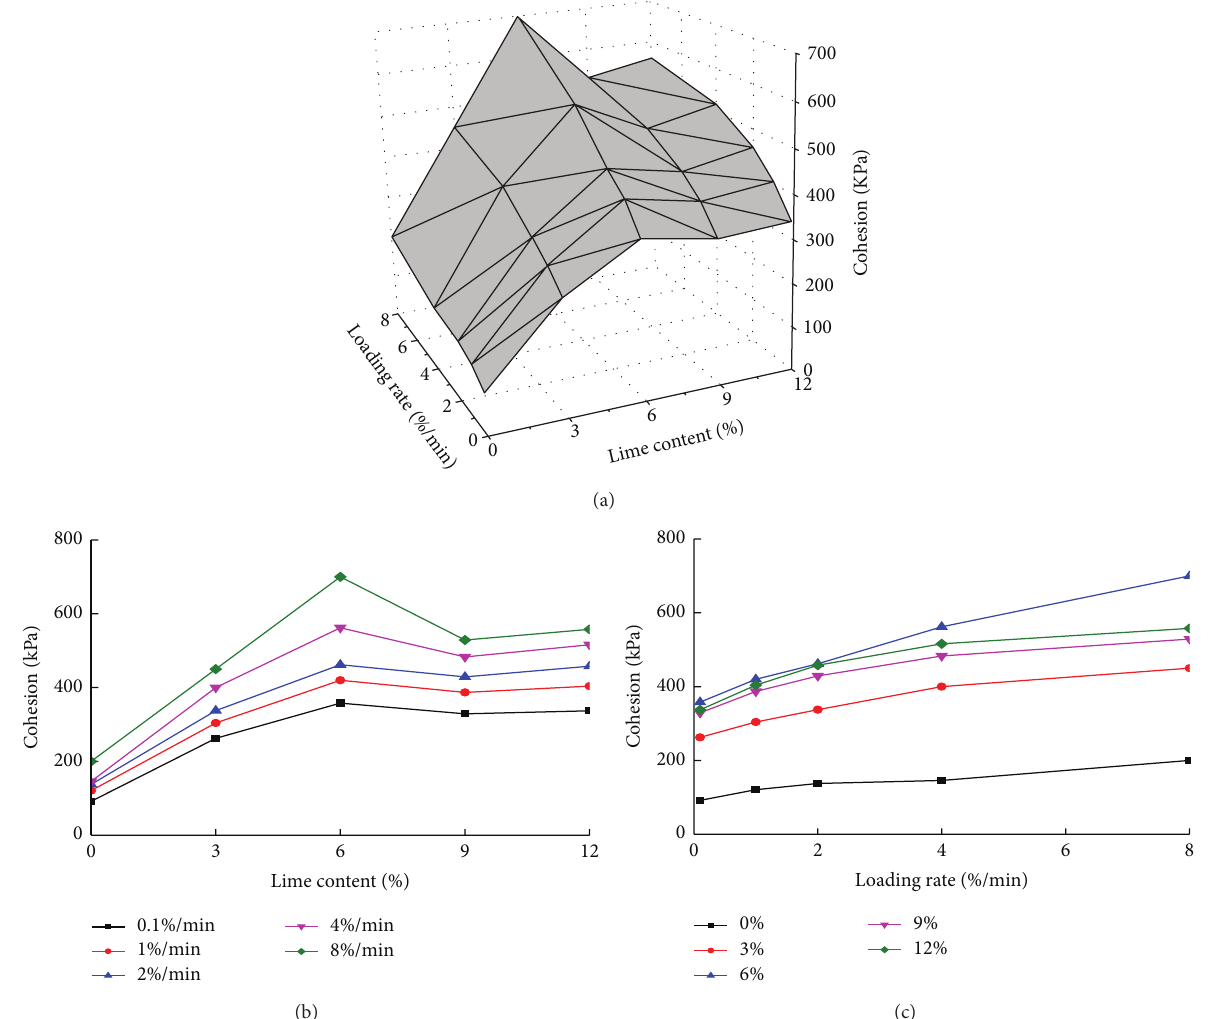
Figure 6: Relation between cohesion and lime content and loading rate of (a) cohesion three-dimensional curved surface (21 days), (b) cohesion lime content (21 days), and (c) cohesion–loading rate (21